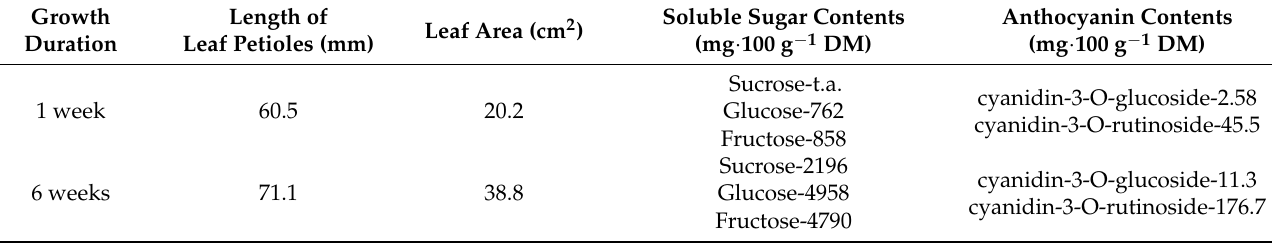
Table 6. Morphological and biochemical characteristics of Rheum ‘Malinowy’ during a 6-week growth period in the greenhouse. Growth